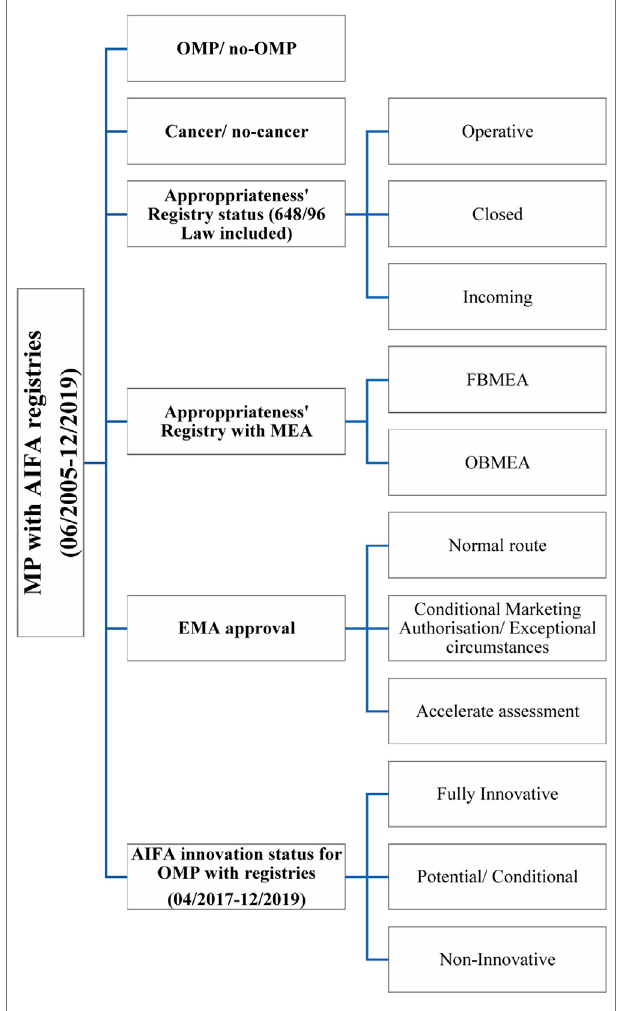
FIGURE 1 | The desktop analysis scheme. MP, medicinal product; OMP, orphan medicinal